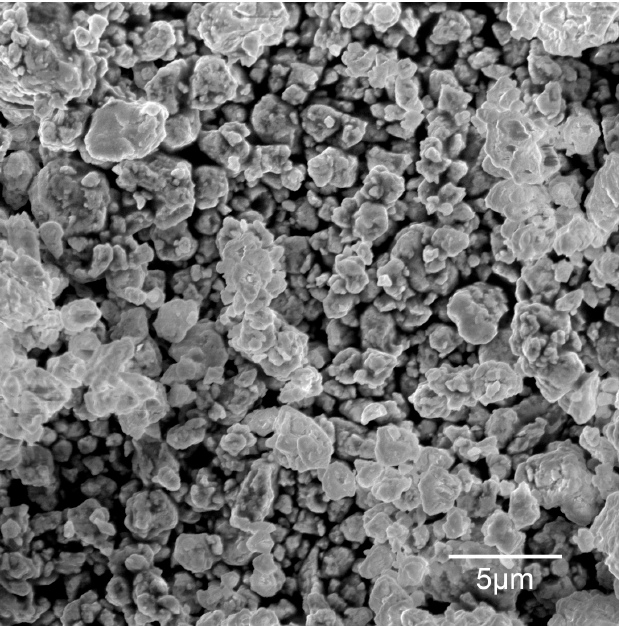
Figure 5. SEM microphotographs of NiAl powder after 10 h of MA.